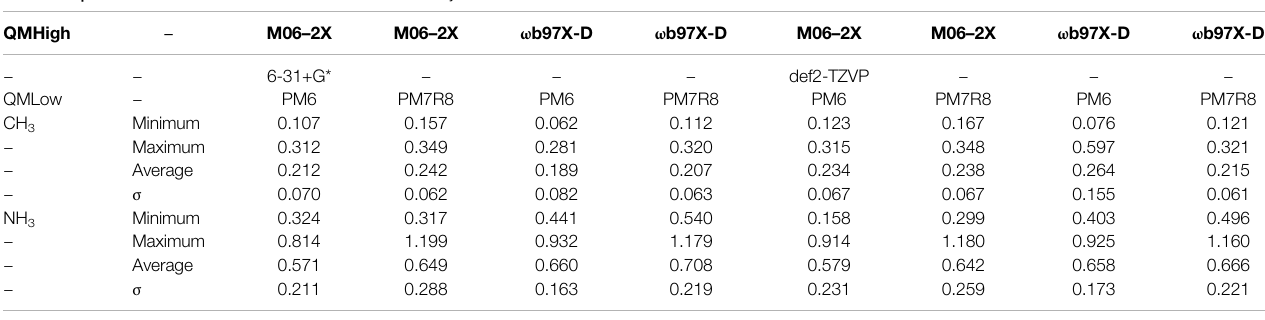
TABLE 3 | Calculated BE ’ s at ONIOM level for tetratomic systems.